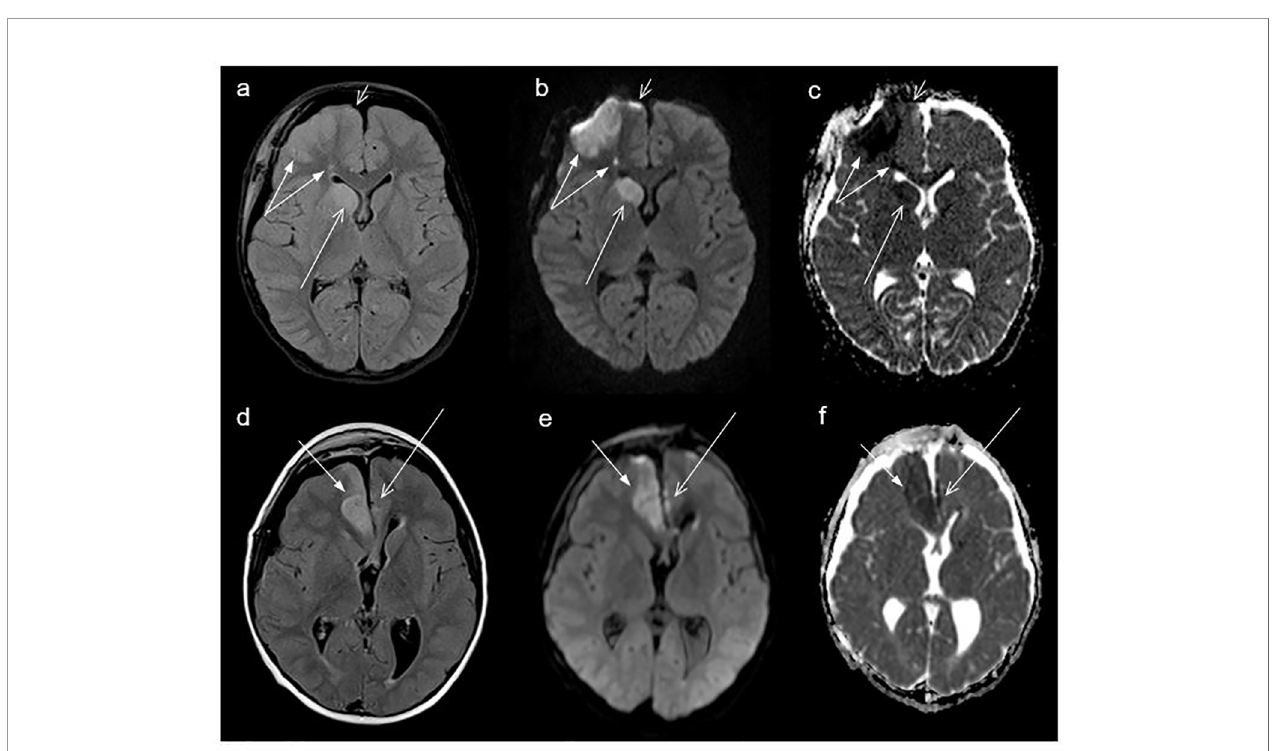
FIGURE 1 | Cranial magnetic resonance imaging (MRI) of a craniopharyngioma patient (case #25, Table 2 ) with cerebral infarction (CI) of middle cerebral artery (MCA) on the right side (double arrow, territorial CI), anterior cerebral artery ACA (Heubner) right side (long arrow), and the top of ACA right side (short arrow, paired with contusions), performed 4 days after surgery (A – C) ; and MRI of a craniopharyngioma patient (case #19, Table 2 ) with cerebral infarction (CI) of the anterior cerebral artery (ACA) on the right side (short arrow) and on the left side (long arrow) showing a linear cortical CI, MRI performed one day after surgery (D – F) . (A, D) show fl uid-attenuated inversion recovery (FLAIR) sequences, (B, E) show DWI b1000, and (C, F) show apparent diffusion coef fi cient (ADC) images, all axial